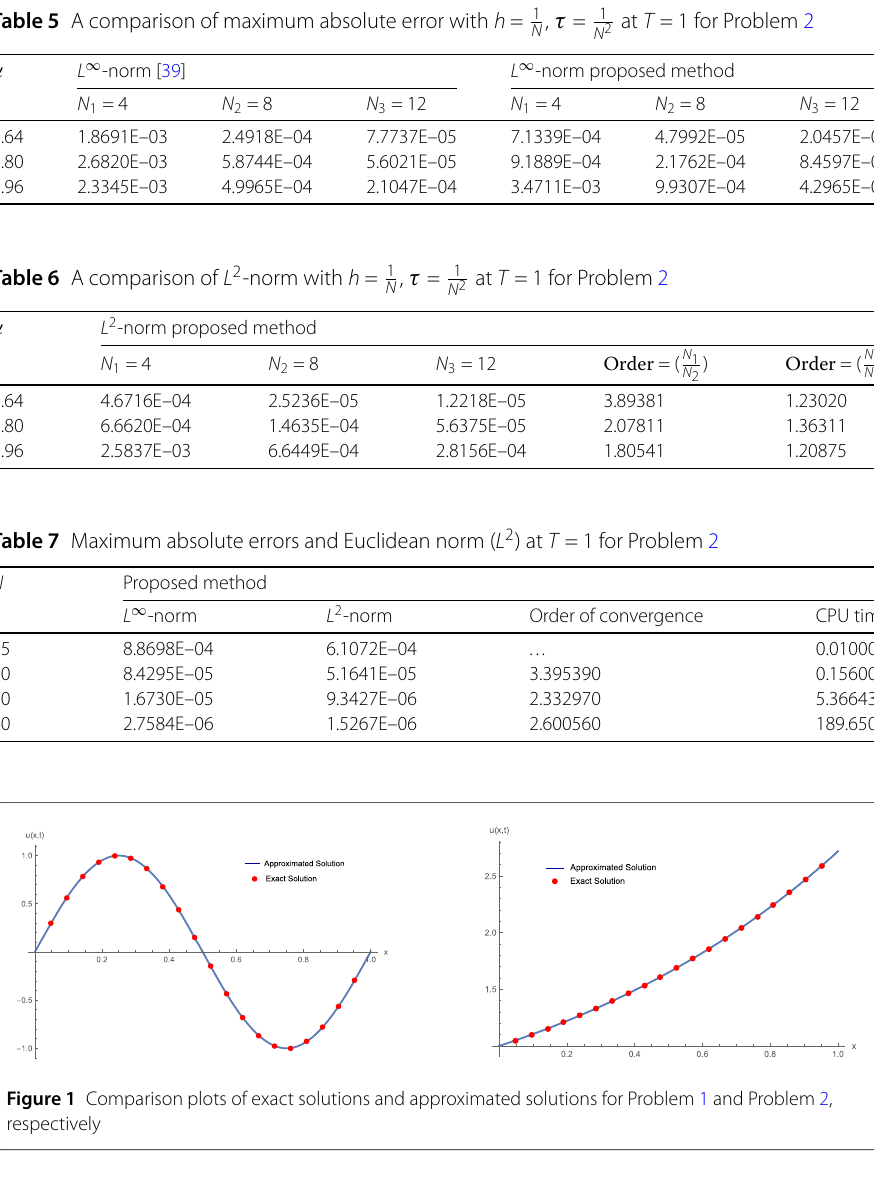
Table 5 A comparison of maximum absolute error with h = 1